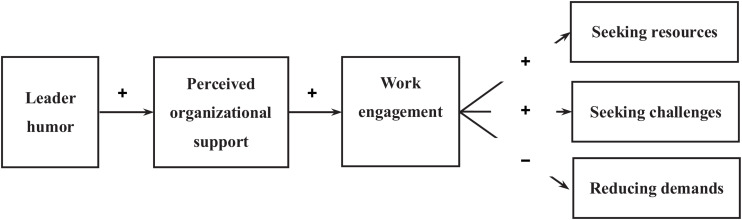
Theoretical model.